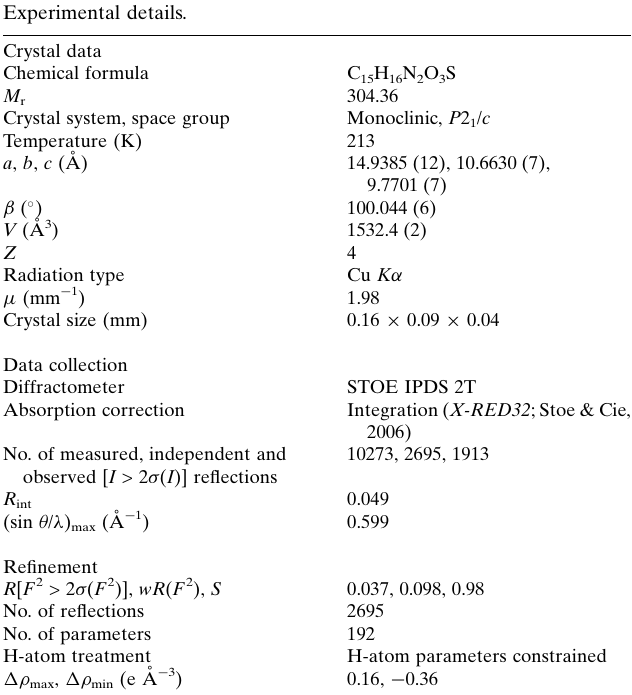
Table 2 Experimental details. Crystal data Chemical formula